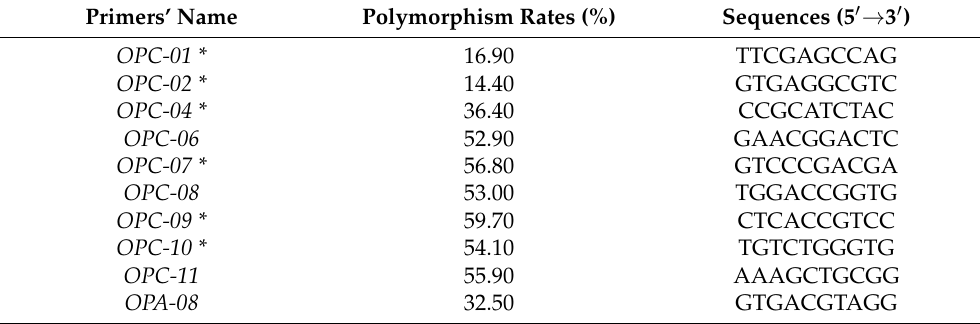
Table 2. Sequences of primers used in RAPD-PCR and the polymorphism rates in the root tissues of